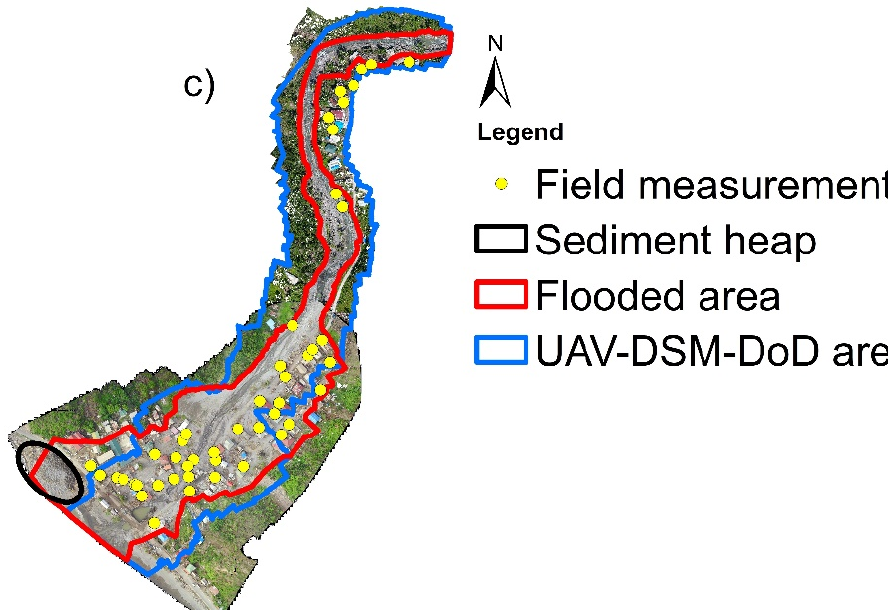
Figure 5. ( a ) Pre-event orthophoto of Coulibistrie. ( b ) Pre-event orthophoto of Pichelin. ( c ) Post-event orthophoto of Coulibistrie with field data collection points. ( d ) Post-event orthophoto of Pichelin with field data collection points; background is a combination of pre-event (transparent) and post-event orthophotos. Note that post-event DSM data do not